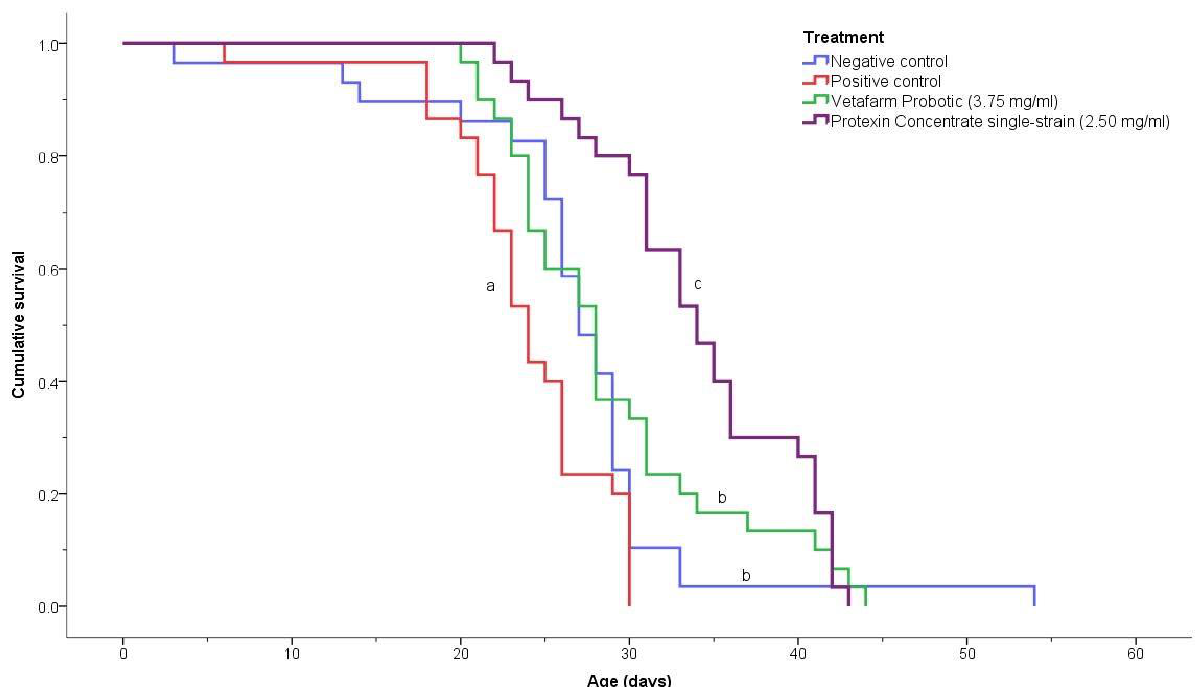
Figure 5. Kaplan-Meier survival curves for N. ceranae -infected honey bees fed the probiotics Vetafarm Probotic and Protexin Concentrate single-strain. Curves labelled with the same letter are not significantly different.